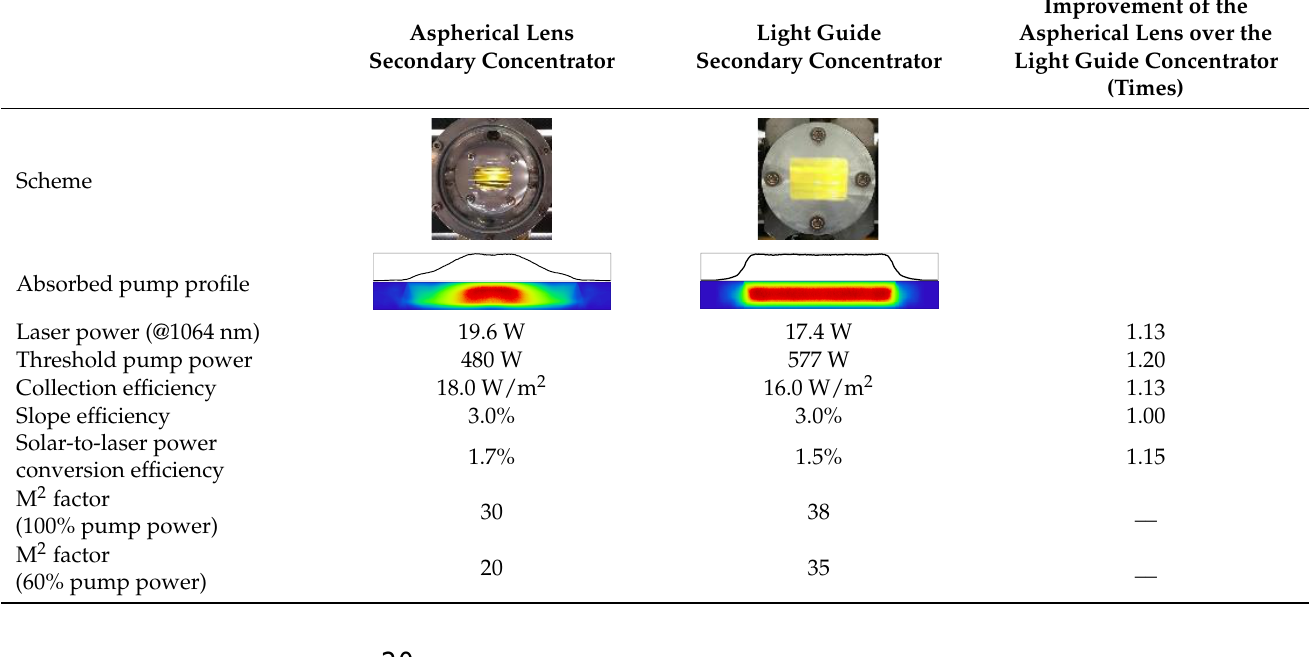
Table 1. Summary of the performance of the Ce:Nd:YAG side-pumped solar lasers with the aspherical lens and the rectangular light guide secondary concentrators.